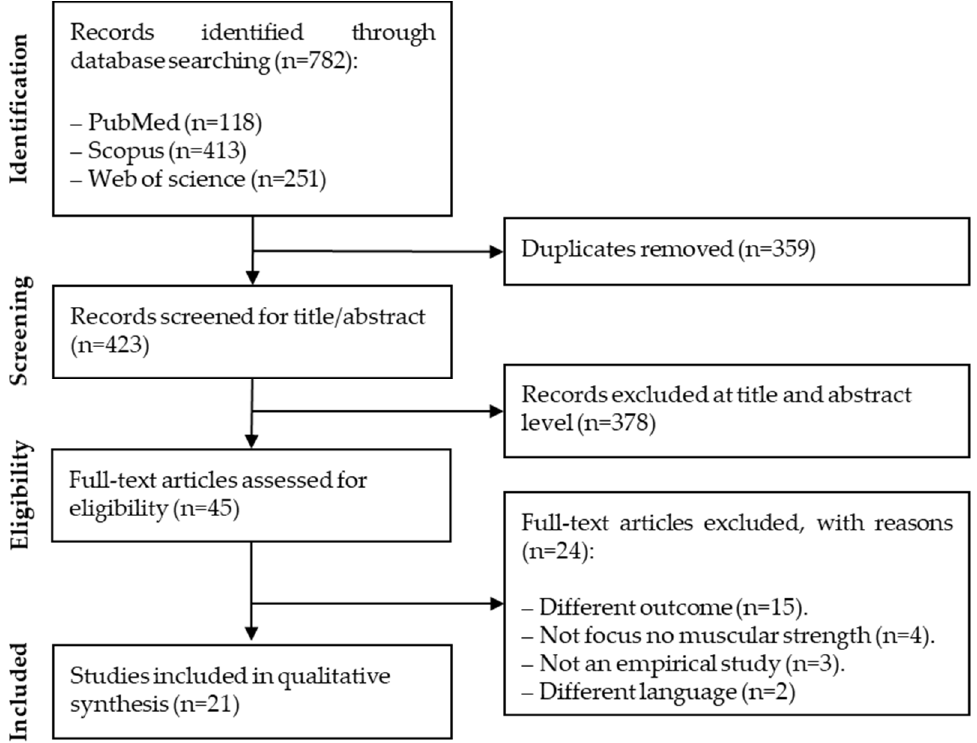
Figure 1. Flow diagram of the study selection.